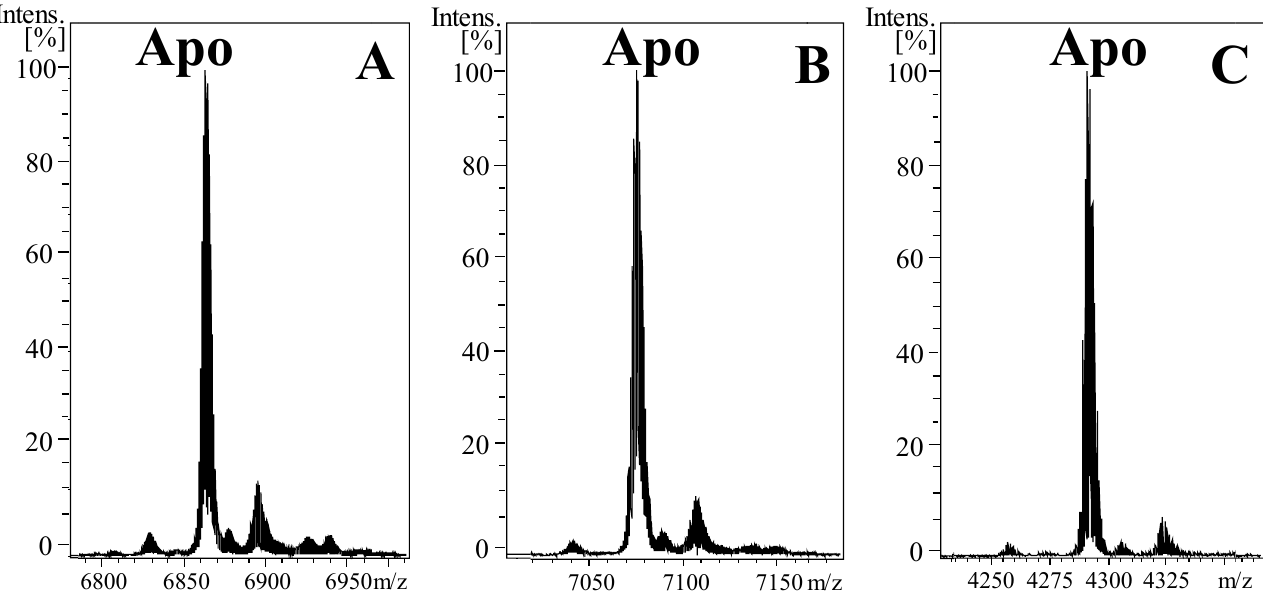
Figure 2. Deconvoluted ESI–MS spectra of ( A ) NpeMT1, ( B ) NpeMT2 and ( C ) β 3NpeMT2 recombinantly produced in Cd-enriched E. coli cultures and recorded at acidic pH (pH 2.4).